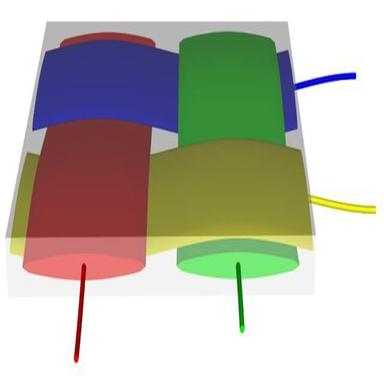
Yarn path and unit cell model.